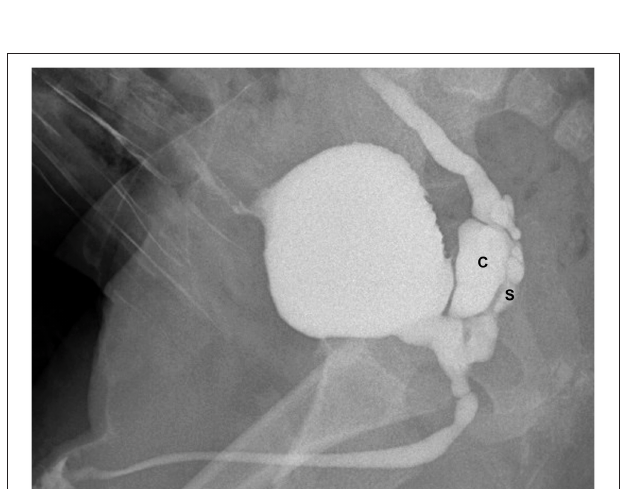
FIGURE 2 | VCUG (lateral view during the micturition) showing dilated right seminal vesicle (S), seminal vesicle cysts (C), and ectopic refluxing right ureter opening into a